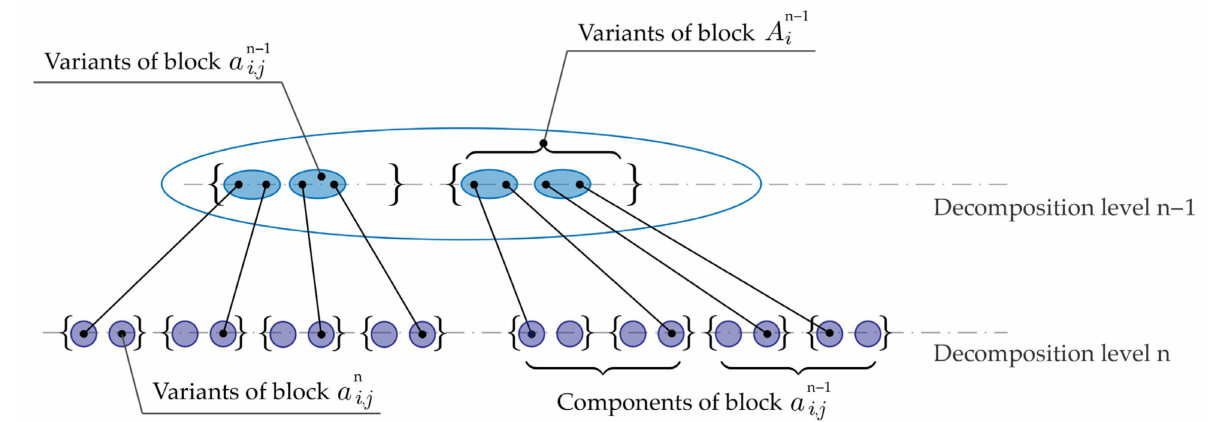
Figure 2. Pattern for choosing the optimal set of blocks.